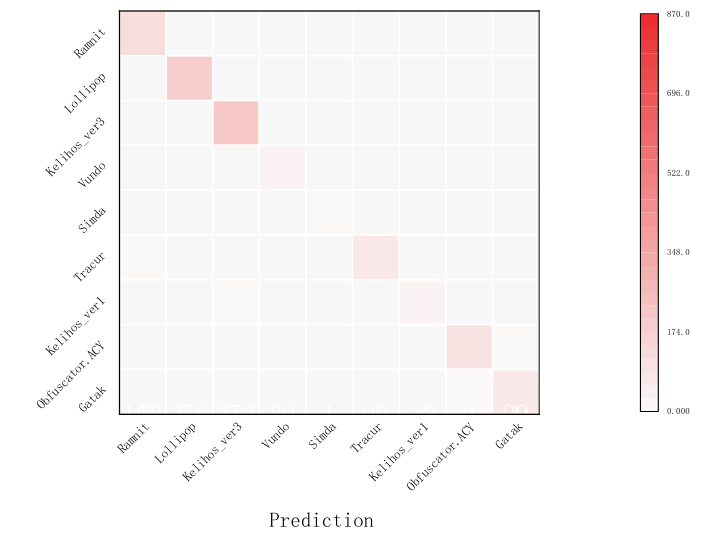
Figure 14. Confusion matrix.